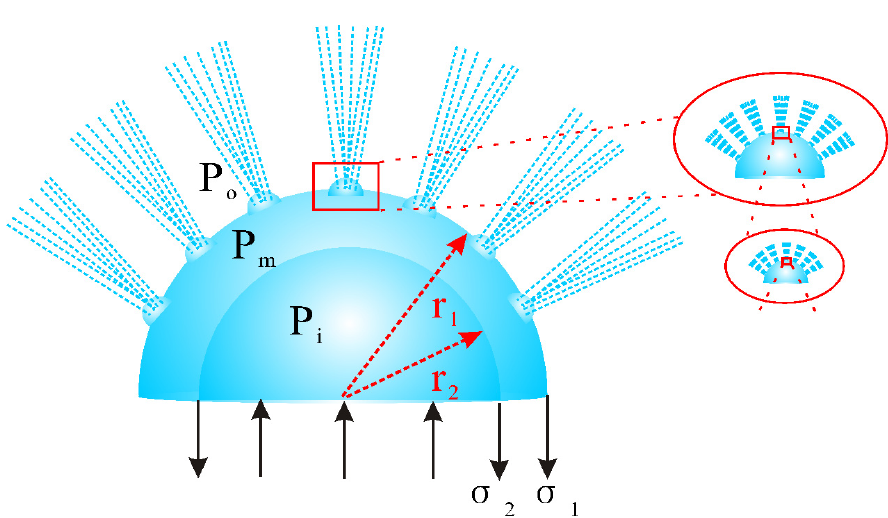
Figure 11. Schematic of hierarchical bubbles in critical bubble electrospinning.